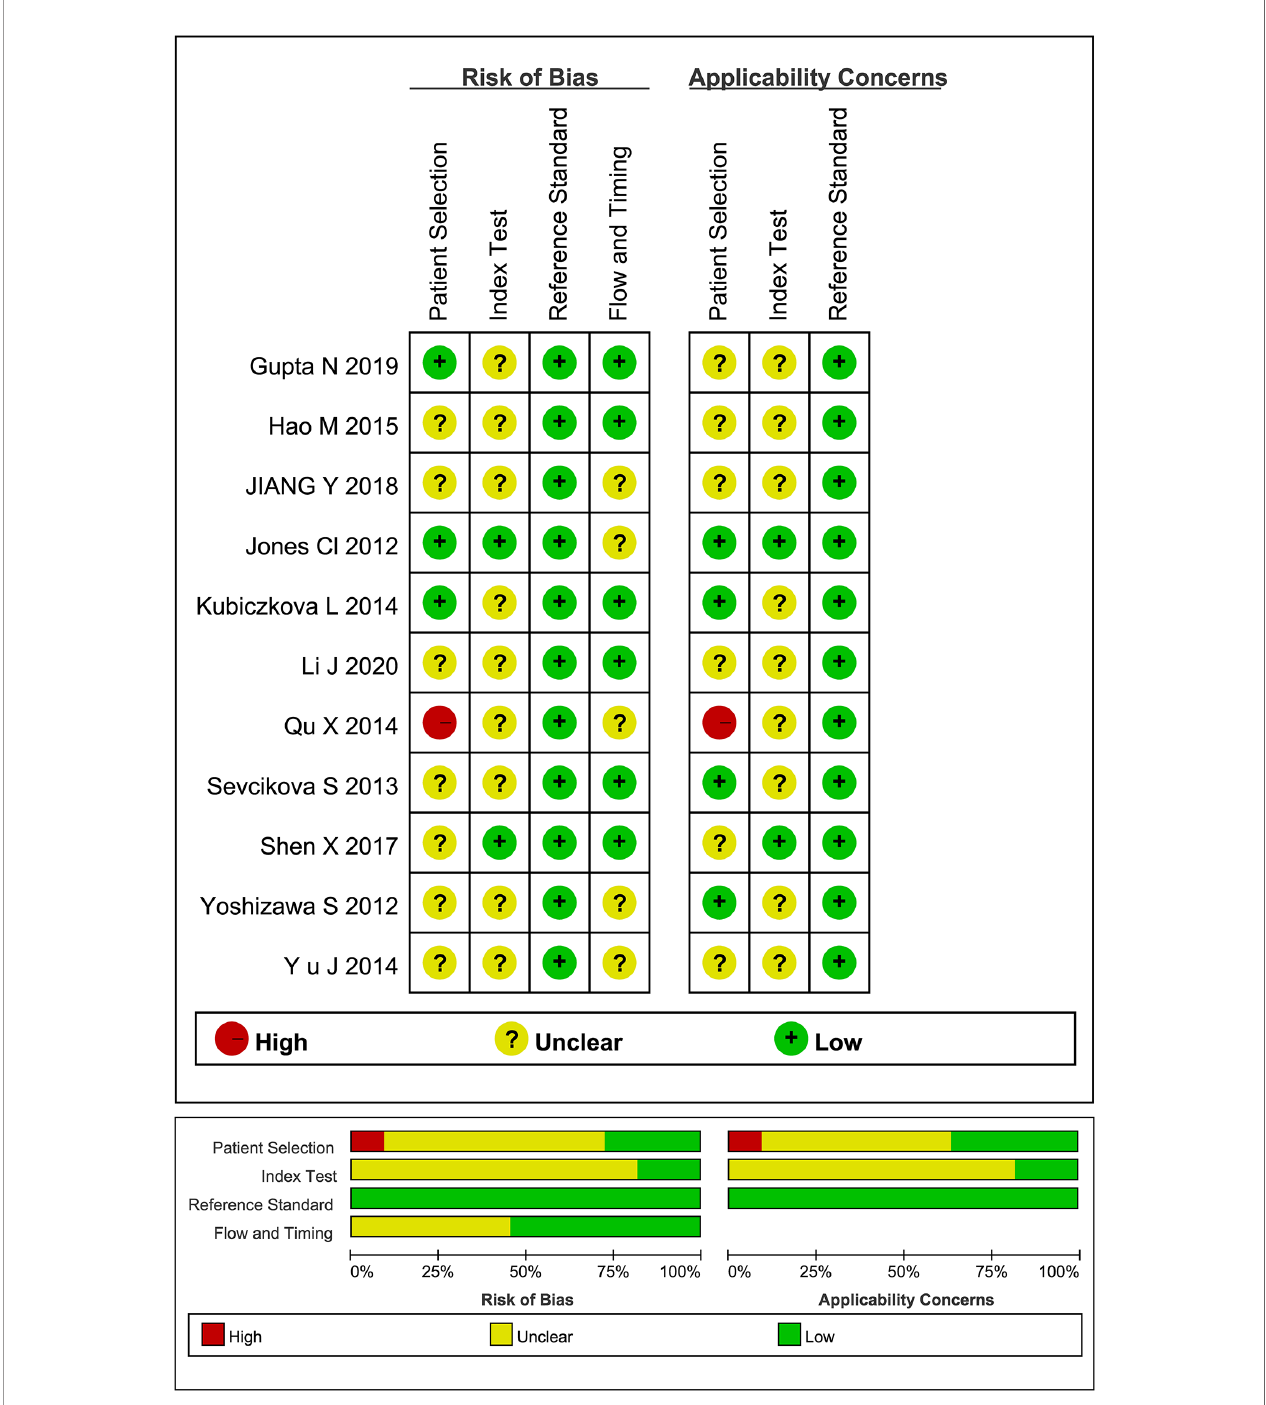
FIGURE 2 | Quality assessment of quali fi ed studies by QUADAS-2